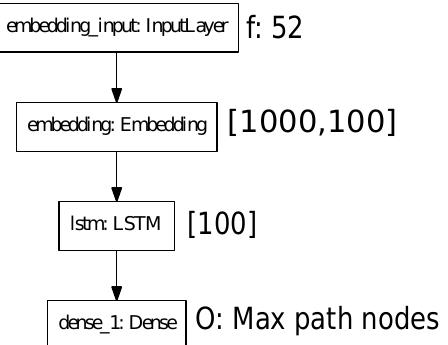
Figure 11. Convolutional model’s features for generating characteristic vector.